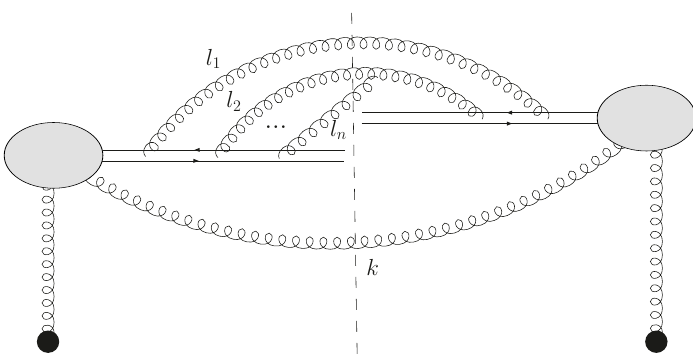
Figure 6 . Multiple soft gluon emissions that give rise to the double leading logarithm contributions at high order. The incoming Wilson line can be e(cid:11)ectively treated as the outgoing conjugate Wilson line. A pair of the Wilson line and the conjugate Wilson line in the fundamental representation can be viewed as one single Wilson line in the adjoint representation in the large N c